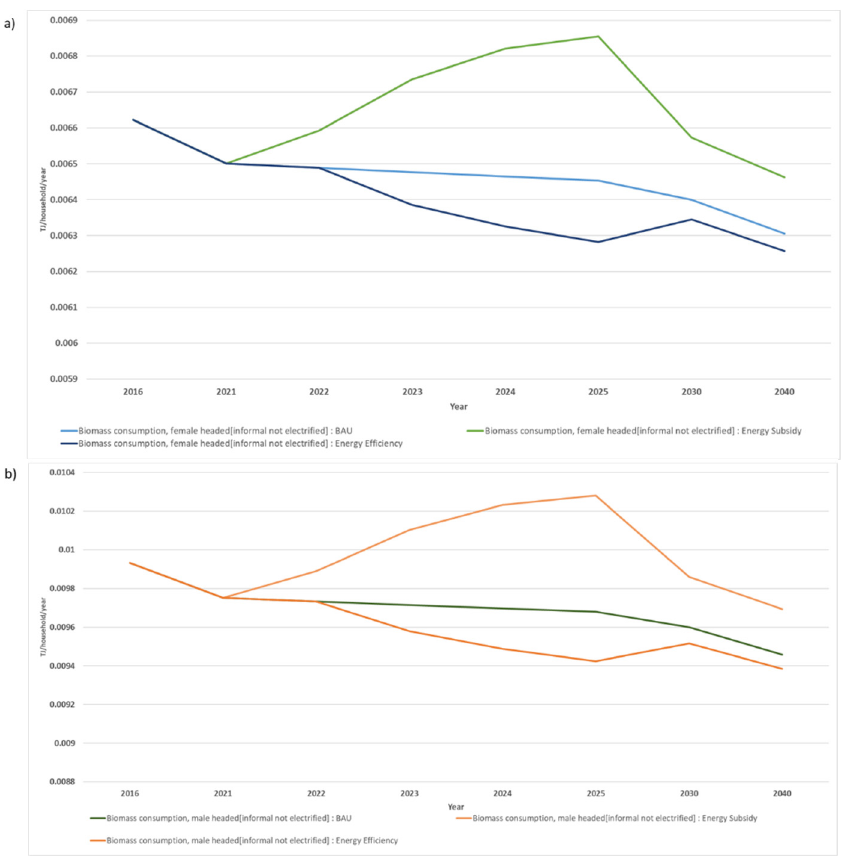
Figure 8. Gendered household biomass energy consumption by dwelling type. Female-headed ( a ) and Male-headed ( b ). Source: